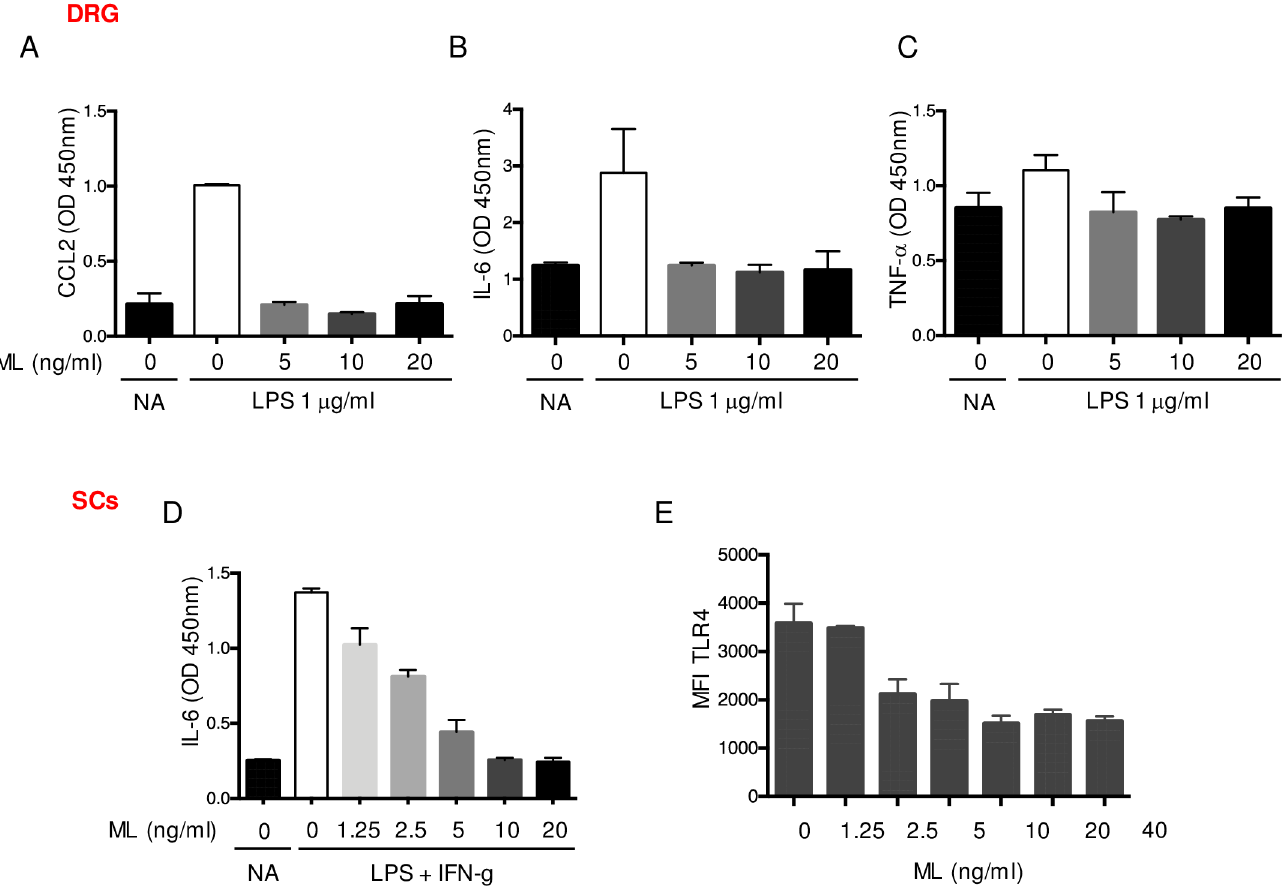
Fig 2. Anti-inflammatory effectsof mycolactone on primary DRG and Schwann cells. Production of CCL-2 (A), IL-6 (B) and TNF- α (C) by mouse dorsal root ganglion (DRG) cells exposedto subtoxic doses of mycolactone (ML) or equivalentvolume of vehicle (DMSO) for 30 min prior to 16 h of stimulationwith 1 μ g/ml LPS. Controls (NA) are vehicle-treated, non-activated cells. (D) IL-6 productionby Schwanncells (SCs) exposedto ML or vehicle(DMSO) for 30 min prior to stimulationwith 1 μ g/m LPS + 20 ng/ml IFN- γ or not (NA). (E) Flow cytometry analysisof TLR4 surface expression by SCs exposedto increasingdoses of ML for 16 h. Data are mean values of OD or MFI ± SEM of triplicates, and are representative of two independent experiments.